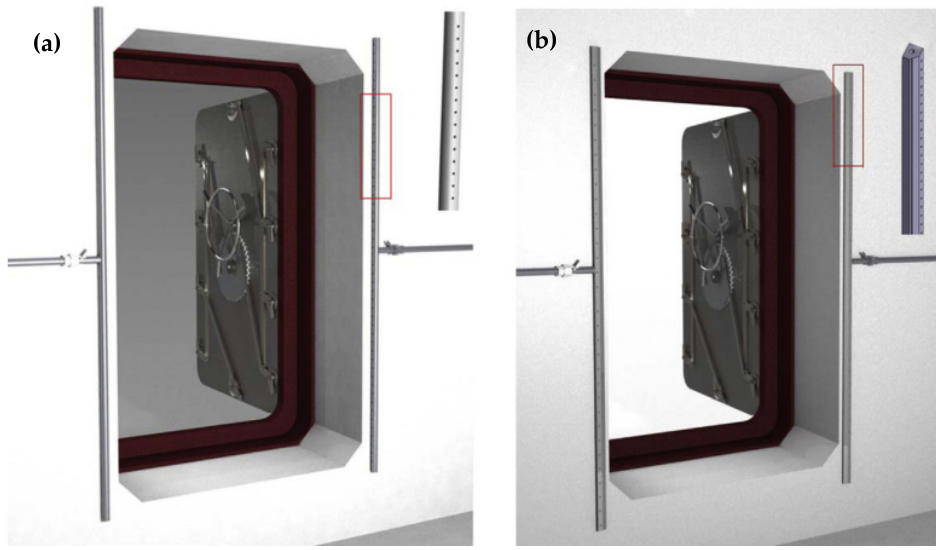
Figure 3. Two main types of air curtain systems for mine refuge chambers in China [79]. ( a ) Pipeline air curtain. ( b ) Air knife.